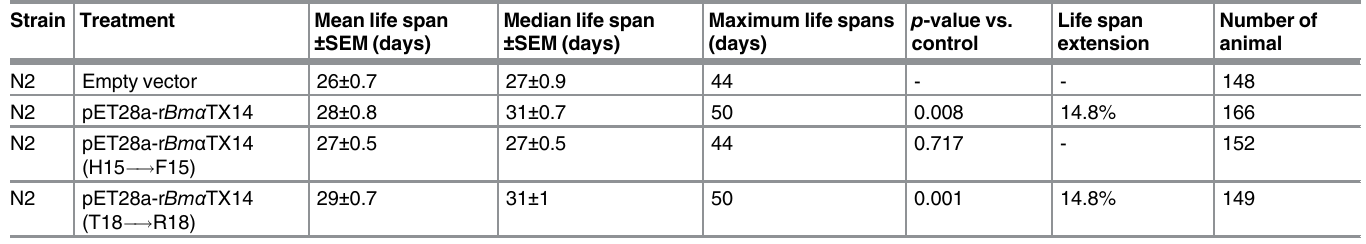
Table 3. Effect of r Bm α TX14 mutations on